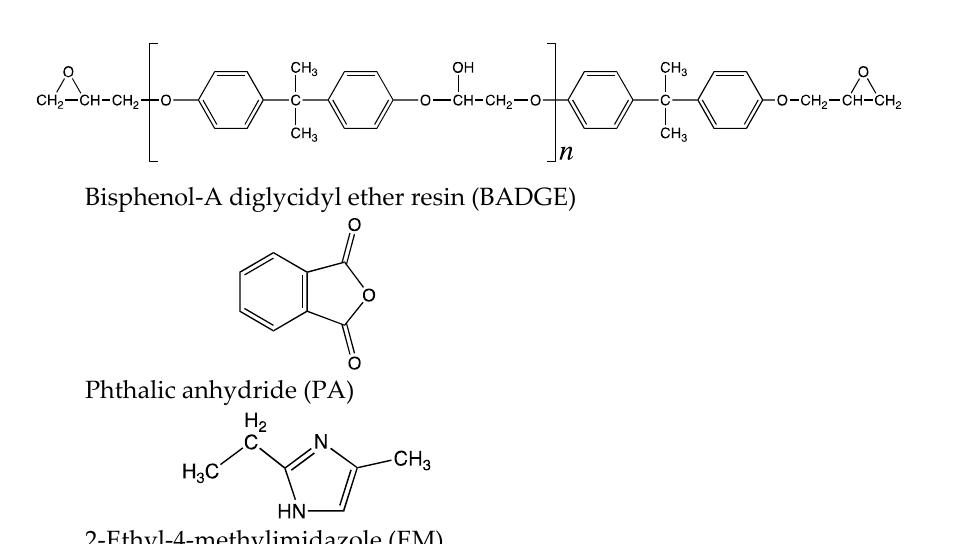
Scheme 2. Chemical formulae of Bisphenol ‐ A diglycidyl ether resin (BADGE), Phthalic anhydride (PA), and 2 ‐ Ethyl ‐ 4 ‐ methylimidazole (EM).